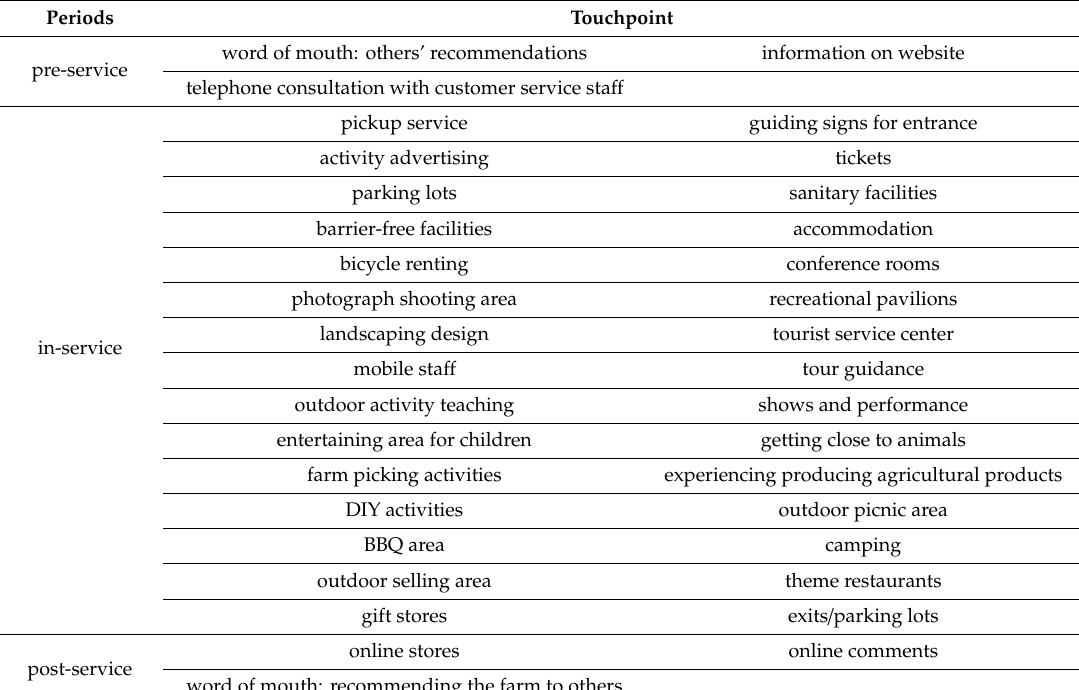
Figure 1. 10 core motivations that affect tourists' vacation to leisure farms. Table 1. Touchpoints of customer journey on leisure